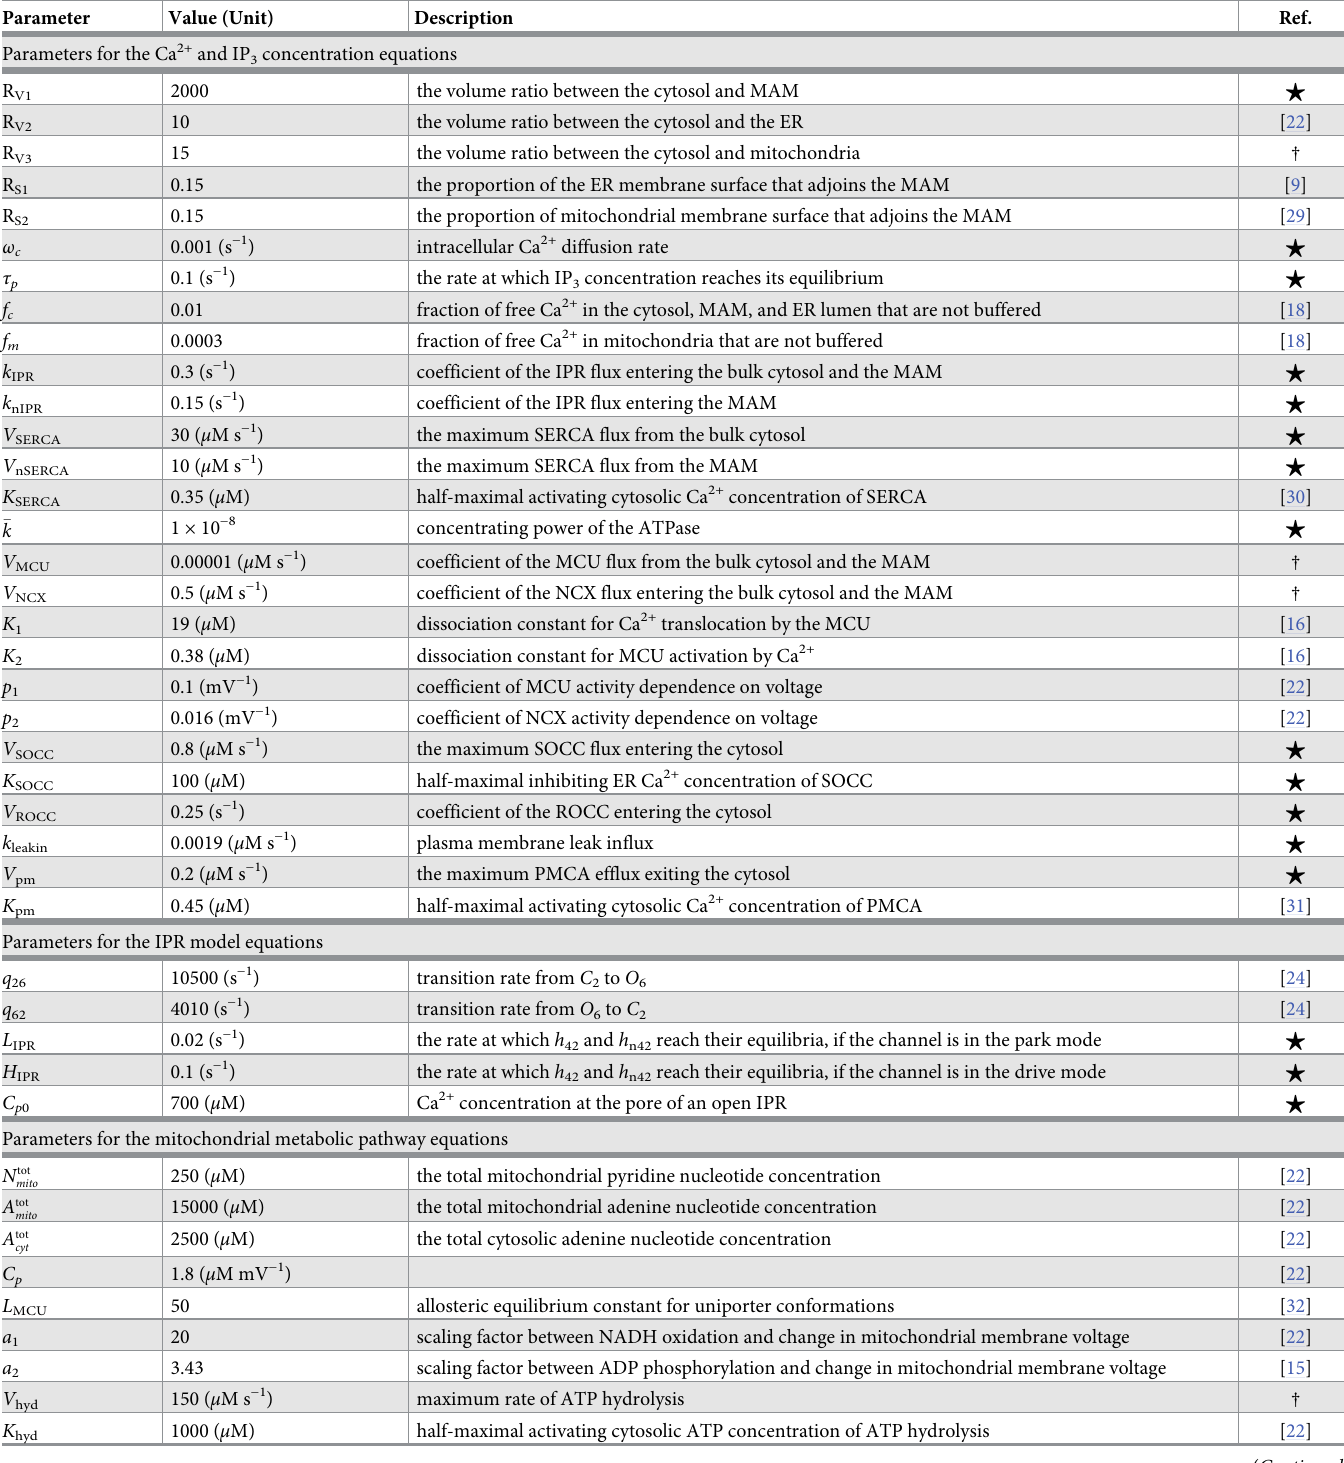
Table 1. Parameter values of the model. The parameters with $ in the reference column are chosen to reproduce some of experimental data reported by Arruda et al. [9]. The parameters with † in the reference column are modified from the original values proposed by Wacquier et al. [22]. The original values are shown at the bottom of the